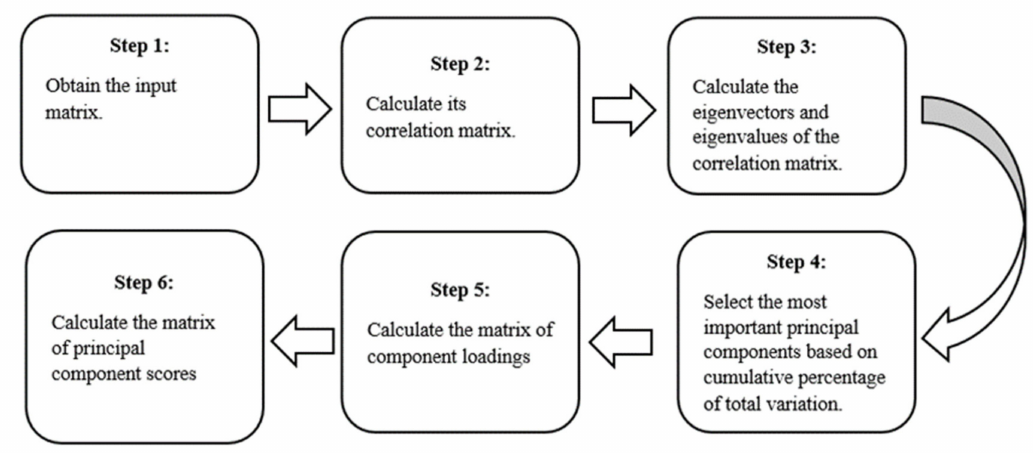
Figure 2. Procedure of employed PCA in monthly rainfall Yogyakarta,